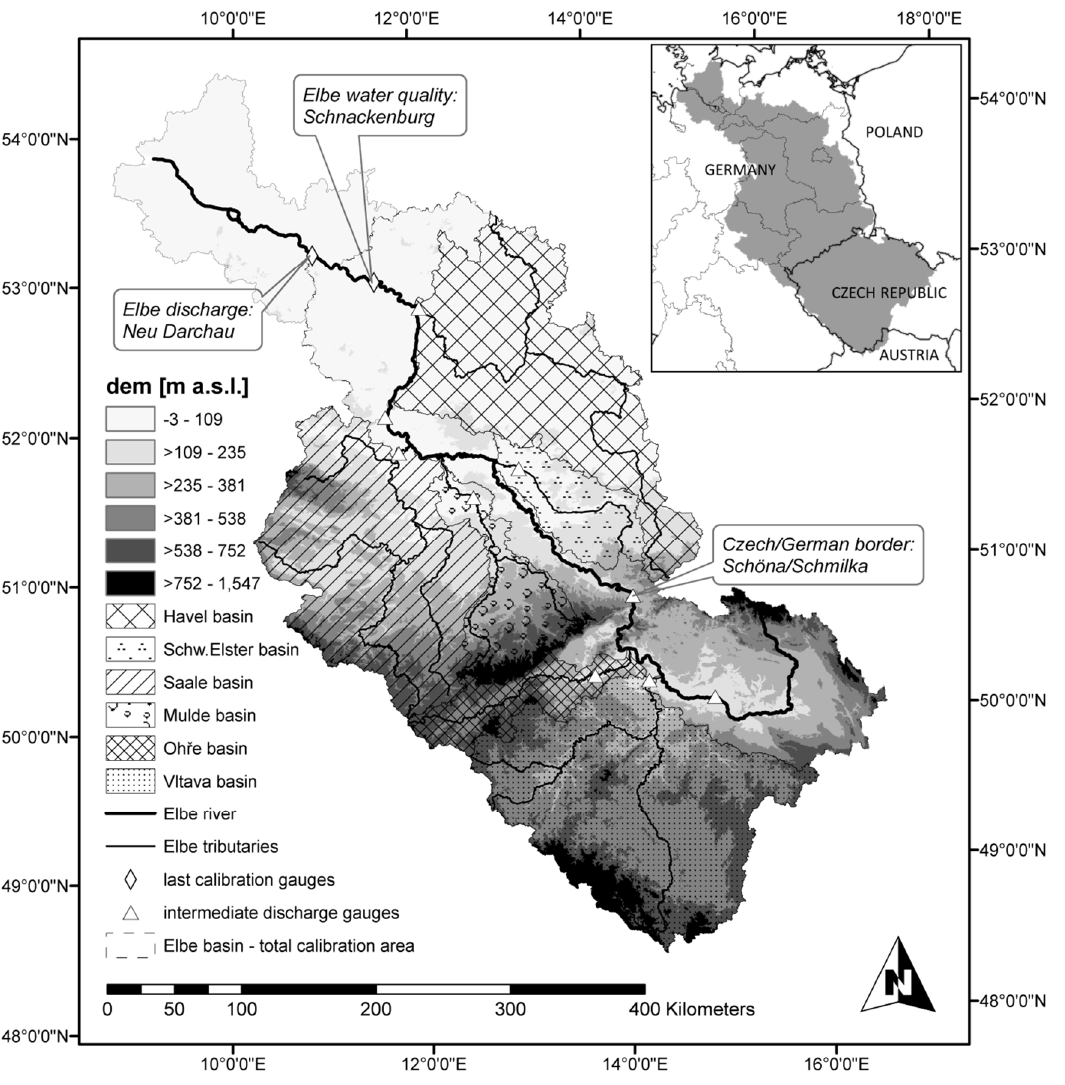
Figure 1. Location and digital elevation model of the Elbe river basin and six catchments of its main tributaries, as well as location of the observation gauges used for calibration.